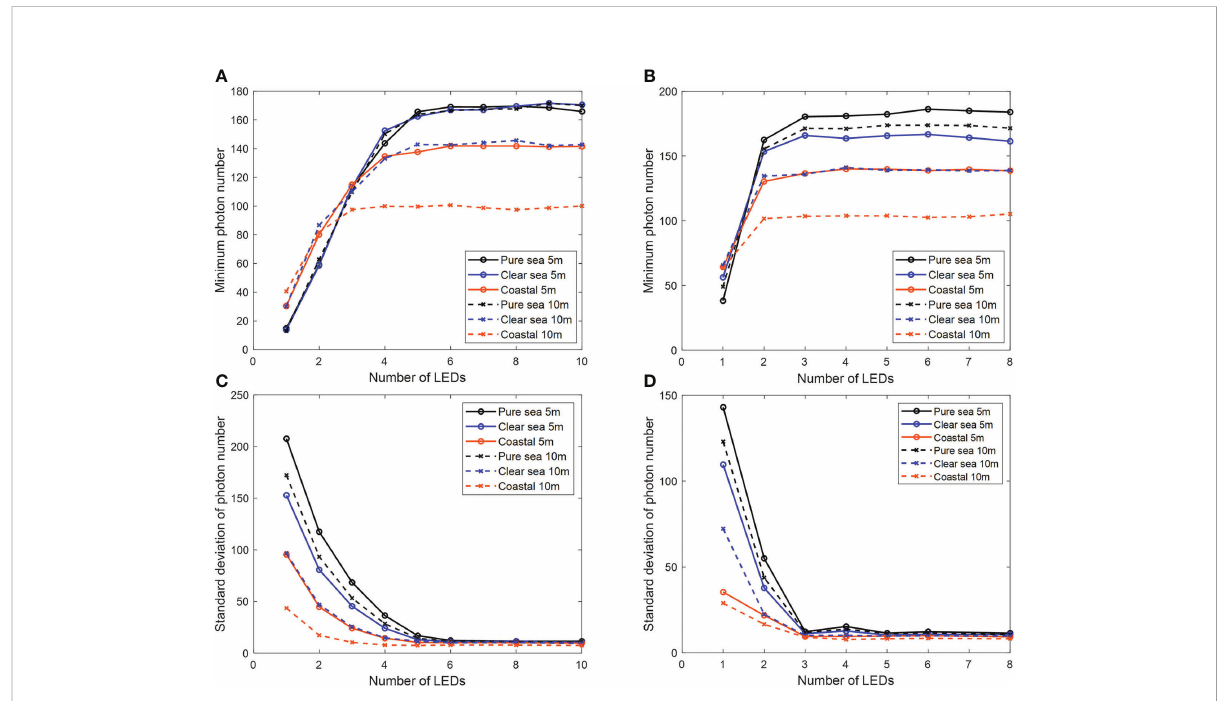
FIGURE 5 Minimum number of photons in the j direction for LED arrays with half power angles of (A) 30° and (B) 60°. Standard deviation of the photon number in the j direction for LED arrays with half power angles of (C) 30° and (D) 60°.